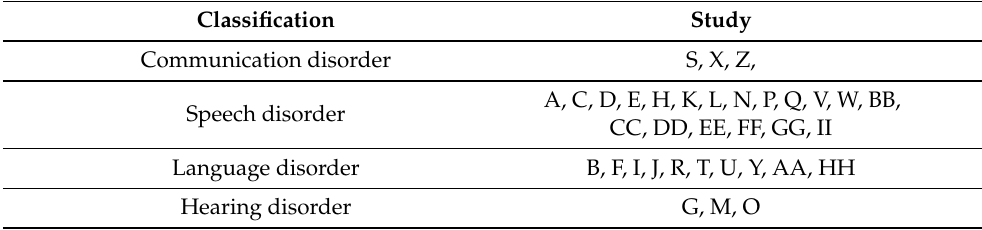
Table 6. Classification of communication disorders.